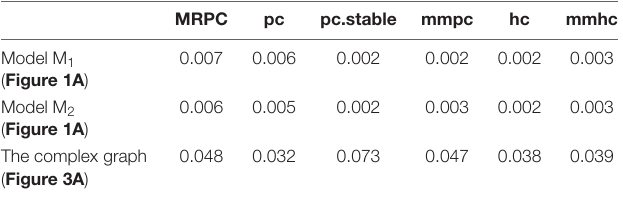
TABLE 4 | Average runtime (in seconds) of each method for three graphs. MRPC pc pc.stable mmpc hc mmhc Model M 1 ( Figure 1A )